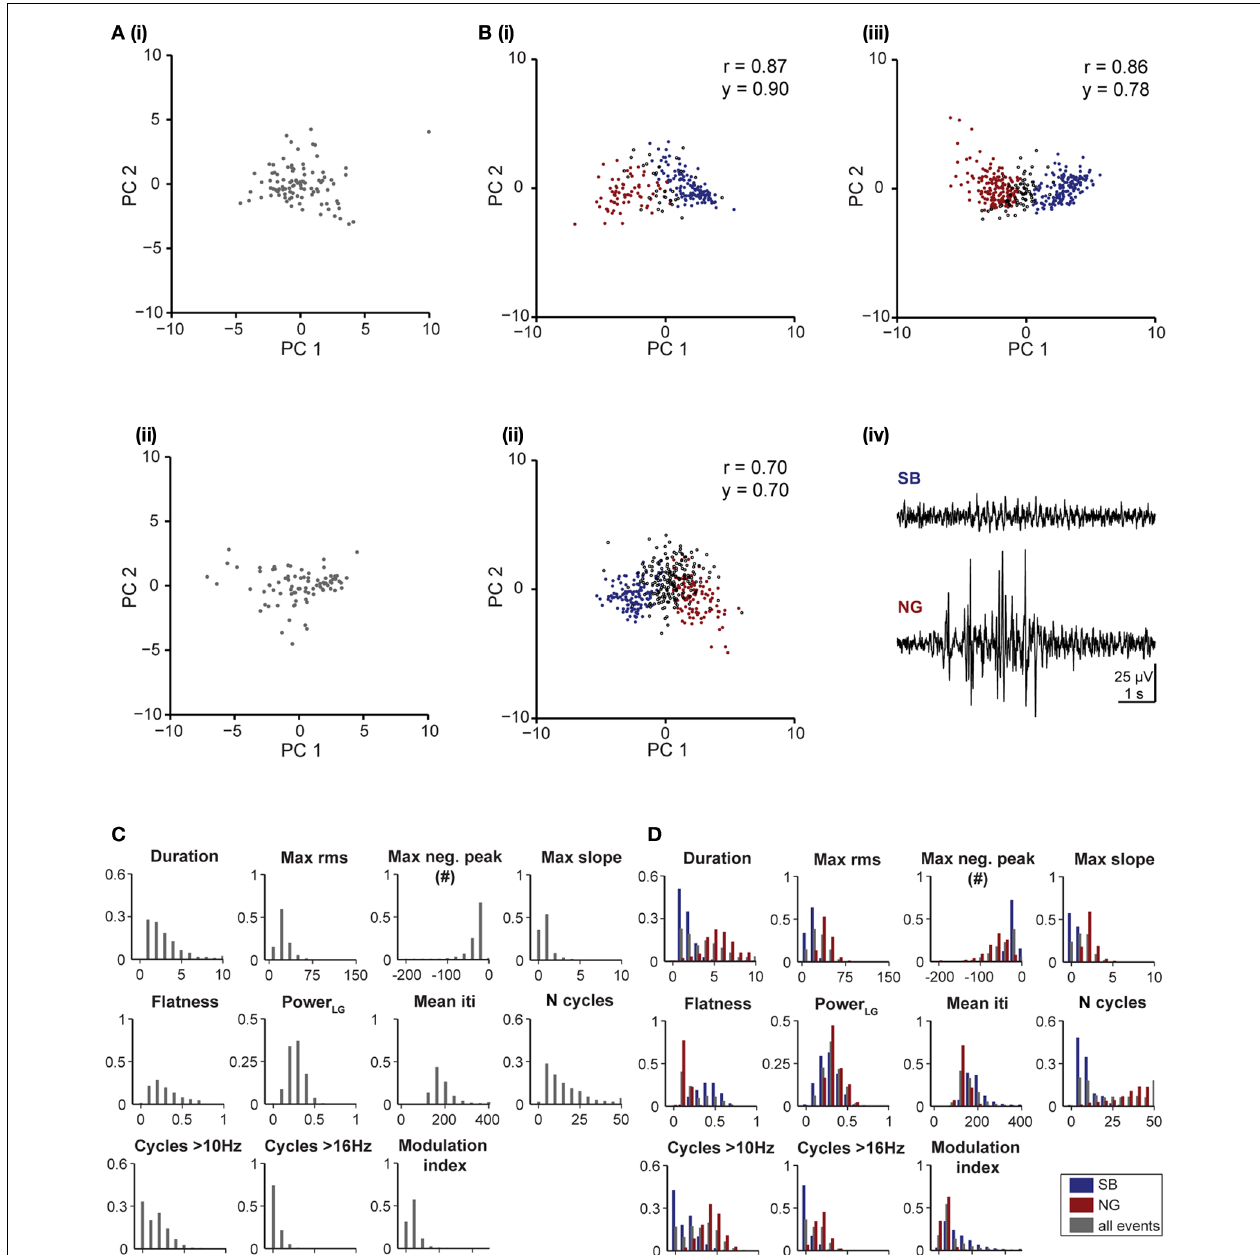
FIGURE 5 | Unsupervised classification of oscillatory events in rat V1 and mouse PL. (A) Clustering of oscillatory events recorded in V1 of two P6 rats. Each dot corresponds to the projection of the feature vector of one event into the principal component space spanned by the first two principal components. (B) Unsupervised classification of oscillatory events (SB in blue, NG in red, UC in white) recorded in the PL of two P8 (i,ii) and one P10 (iii)